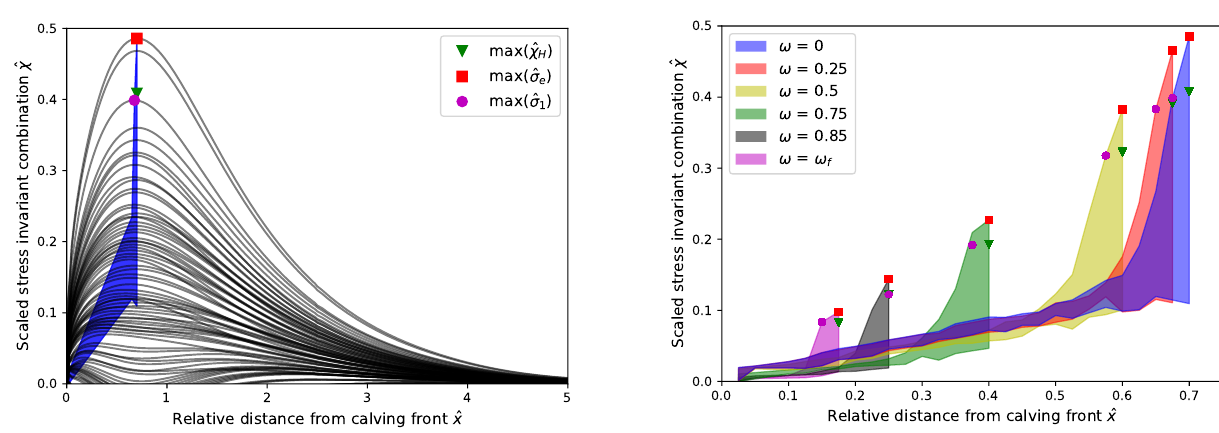
Figure 9. Envelopes of stress invariant combinations at the surface of the idealized glacier with zero basal motion for varying relative water level ω . The green triangle, red square and purple circle rep- resent the maximum of the scaled Hayhurst stress, von Mises stress and maximum principal stress, respectively, for each water